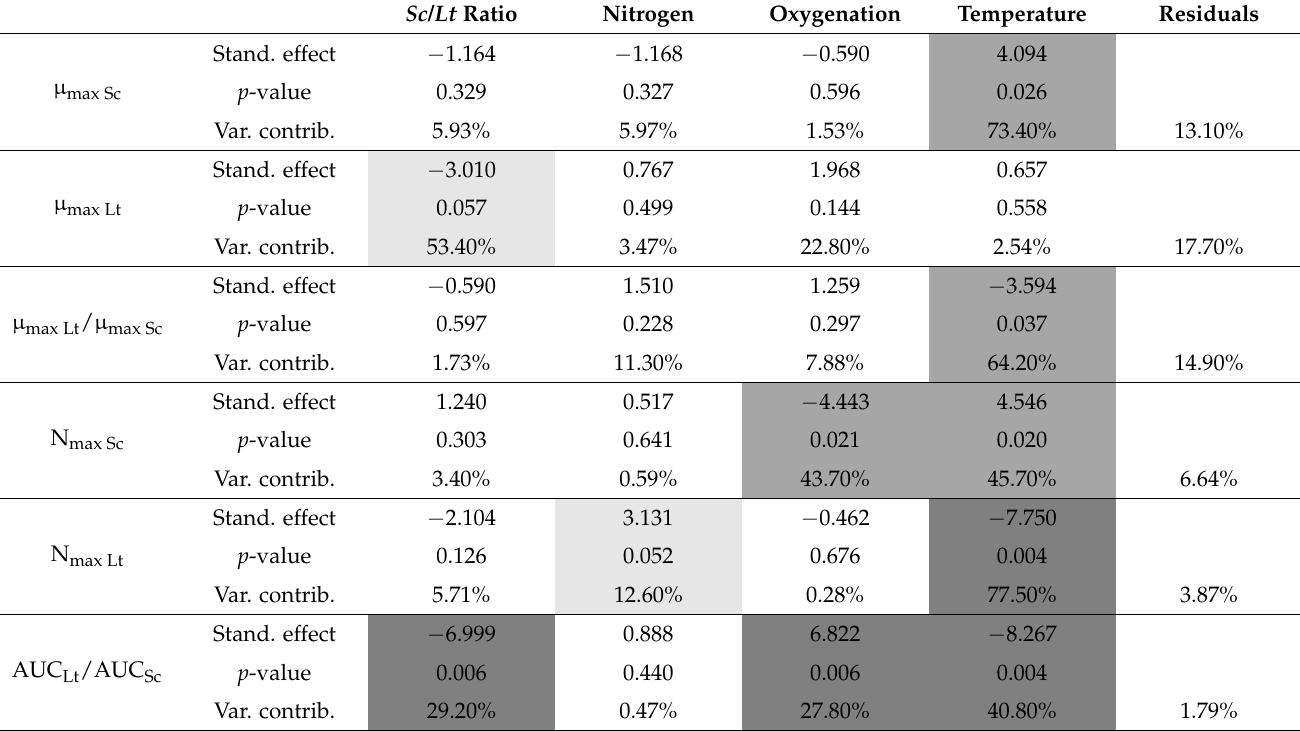
Table 3. Impact of fermentation parameters on population dynamics ( µ max , N max ,